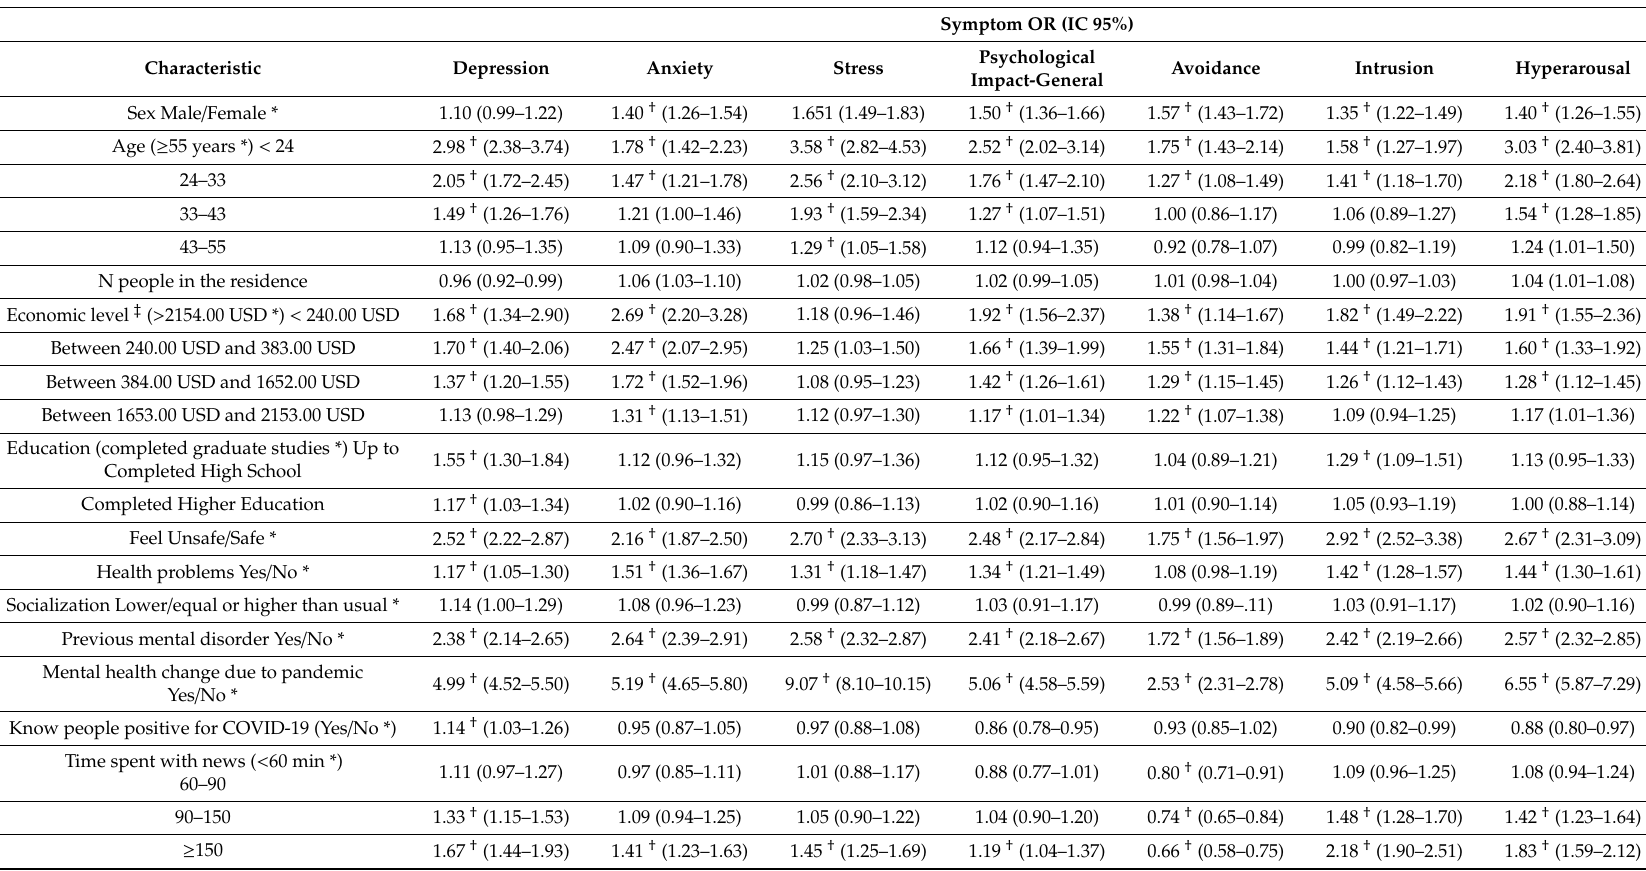
Table 4. Odds ratio (OR) with 95% confidence interval (95% CI) for psychological symptoms (0 = Absent / 1 = Present) according to characteristics of